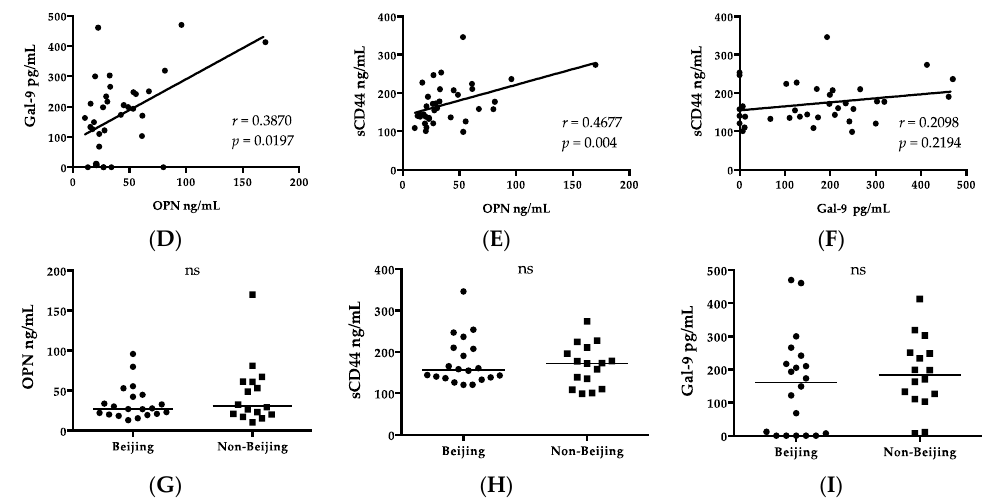
Figure 1. OPN, Gal-9 and sCD44 in groups under study. Comparison of plasma levels of OPN ( A ); Gal-9 ( B ); and sCD44 ( C ) among HC, LTBI, and TB patients. Correlations among OPN, Gal-9, and sCD44 in TB patients ( D – F ); comparison of OPN ( G ); Gal-9 ( H ); and sCD44 ( I ) between Beijing and non-Beijing genotype.